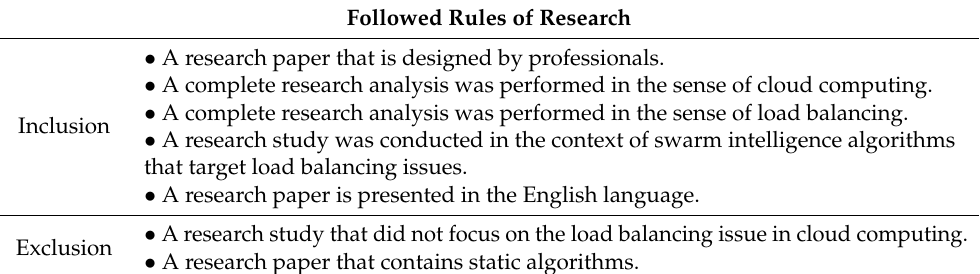
Table 2. Rules of the search inclusion and